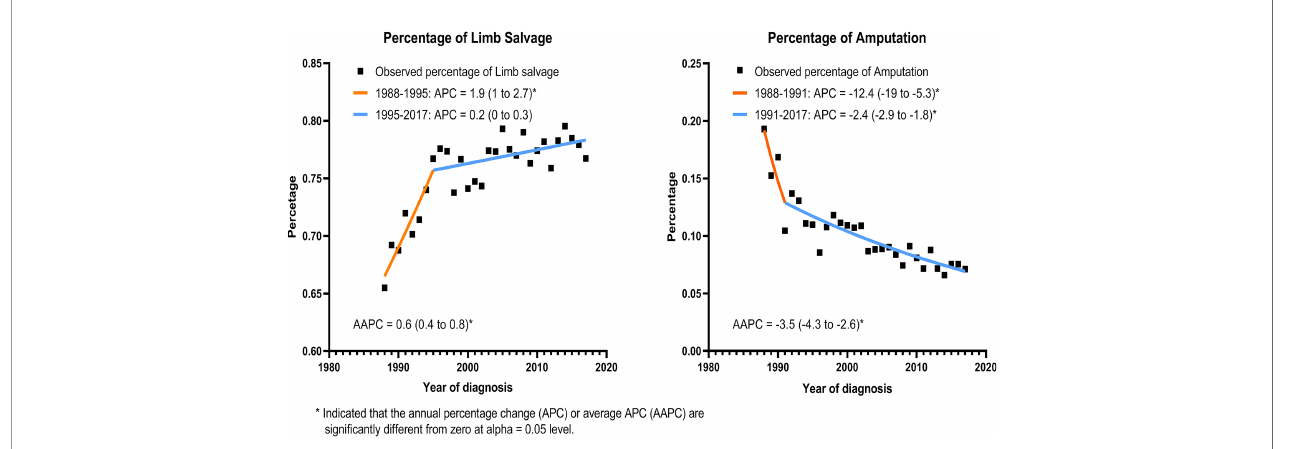
FIGURE 2 | Incidence of limb salvage and amputation with calendar year among all patients with EBST